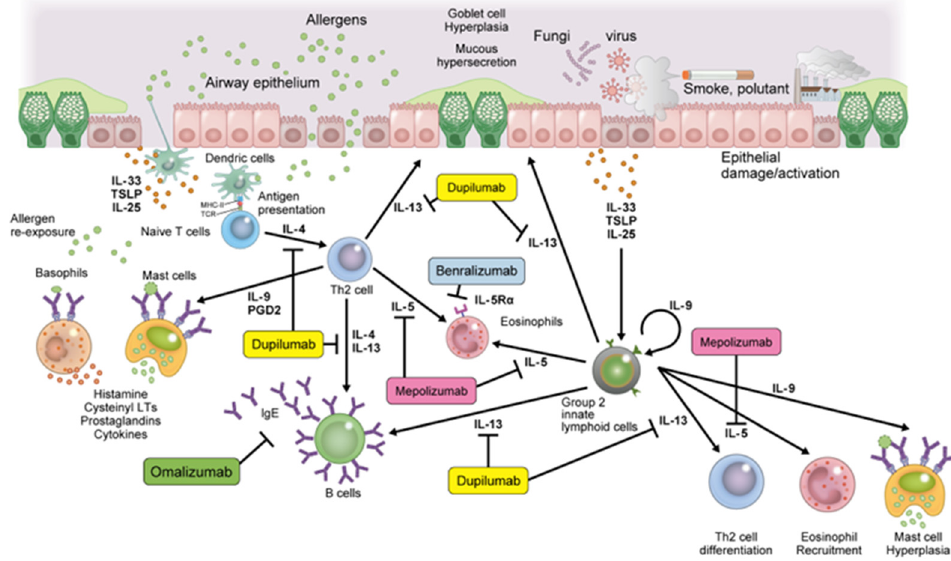
Figure 2. Th2 allergen responses in the asthmatic airway and suppression effect of biological drugs in childhood asthma.